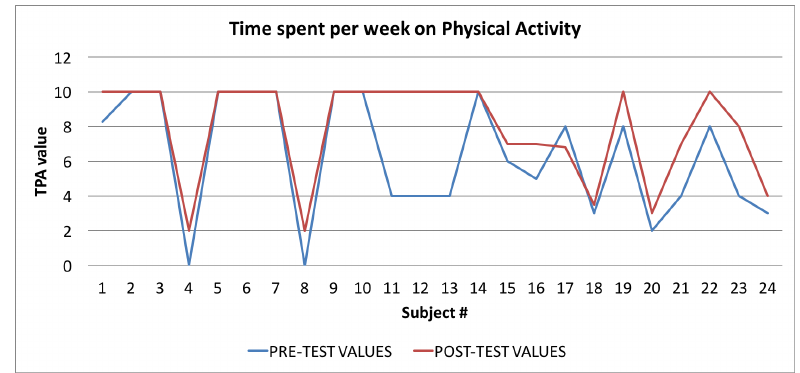
Figure 11. Time spent per week on Physical Activity Index: averages of the values calculated at the beginning (blue line) and at the end of the trial (red line).